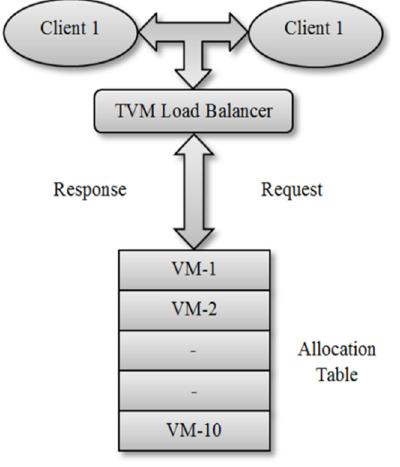
Figure 3. The process of the throttled algorithm [1]. Table 2. Pros and cons of the load-balancing algorithm. Strategy